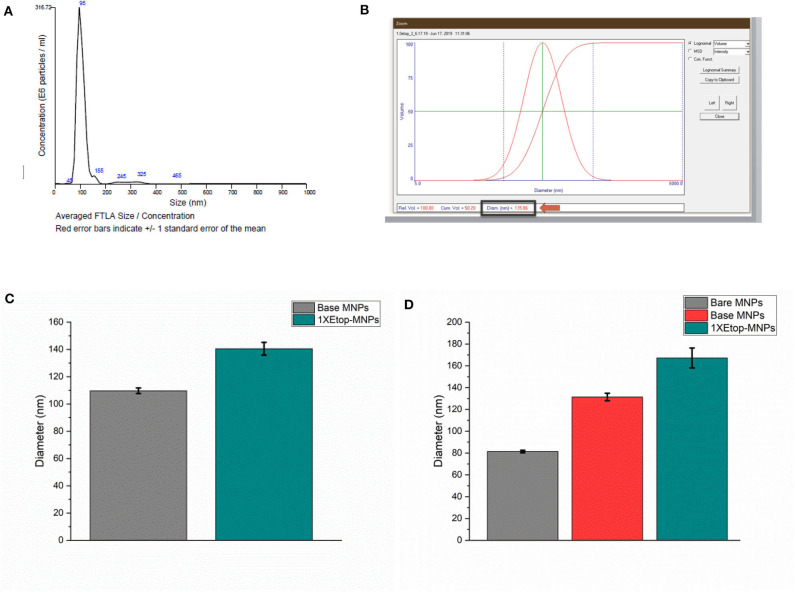
Analysis of base versus Etop -MNP diameters. (A) Representative histogram from the Nanosight instrument, which indicates particle size by Brownian motion. (B) Representative data (“screen shot”) from the NanoDLS instrument, which determines particle size by dynamic light scattering. (C) Bar graph showing mean diameter of base MNPs versus Etop-MNPs suspended in PBS, as determined by the NanoDLS instrument. The Etop-MNPs are slightly larger due to the coating with biotinylated etoposide. (D) Bar graph showing independent analysis of base MNP versus Etop-MNP particle size using the Zetasizer instrument, in sodium phosphate solution, in which the particles showed a higher stability. For (C,D), data are expressed as mean ± SEM with n = 3.